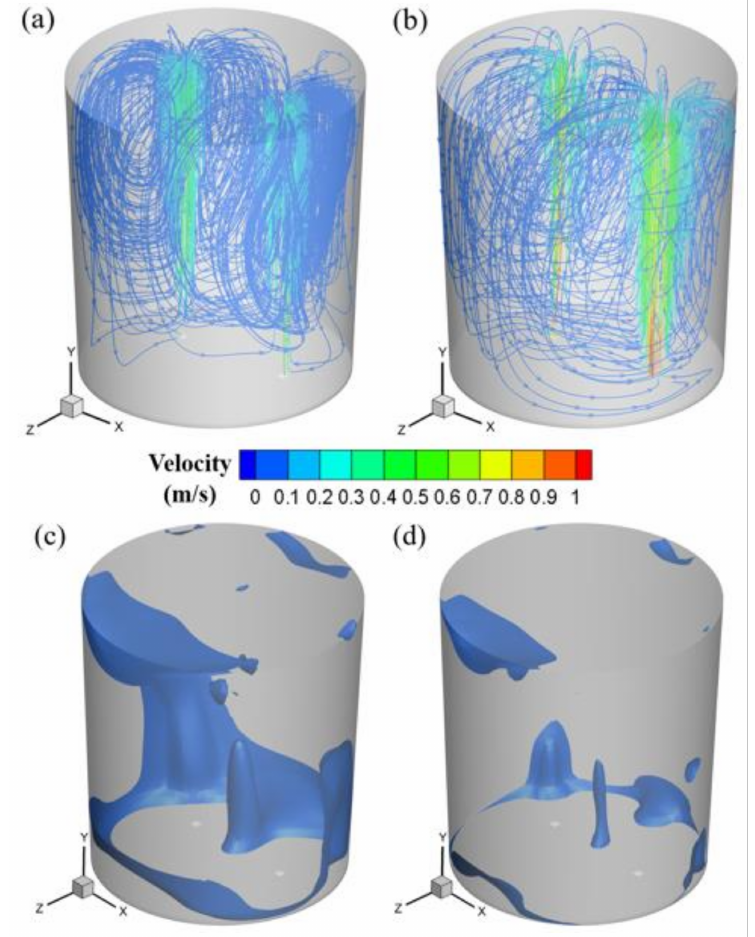
Figure 9. Flow parameters of water in model ladle with dual bottom plugs under different flow rates: ( a ) streamline of 0.6 m 3 /h; ( b ) streamline of 3.0 m 3 /h; ( c ) stagnant region of 0.6 m 3 /h; ( d ) stagnant region of 3.0 m 3